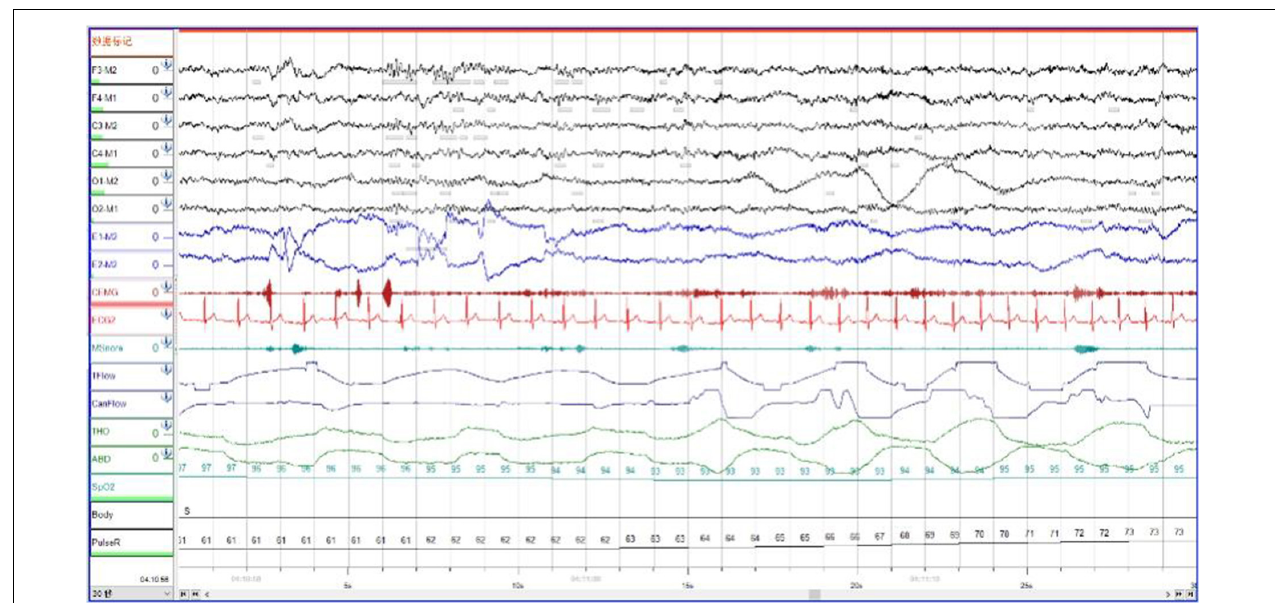
FIGURE 2 | Complex behaviors were detected during N3 sleep through video. The specific movements are as follows: he suddenly sat up from N3 sleep stage with eyes opened widely, shouted, and aimlessly moved his limbs. (A–F) Indicates the order in which abnormal actions occur.